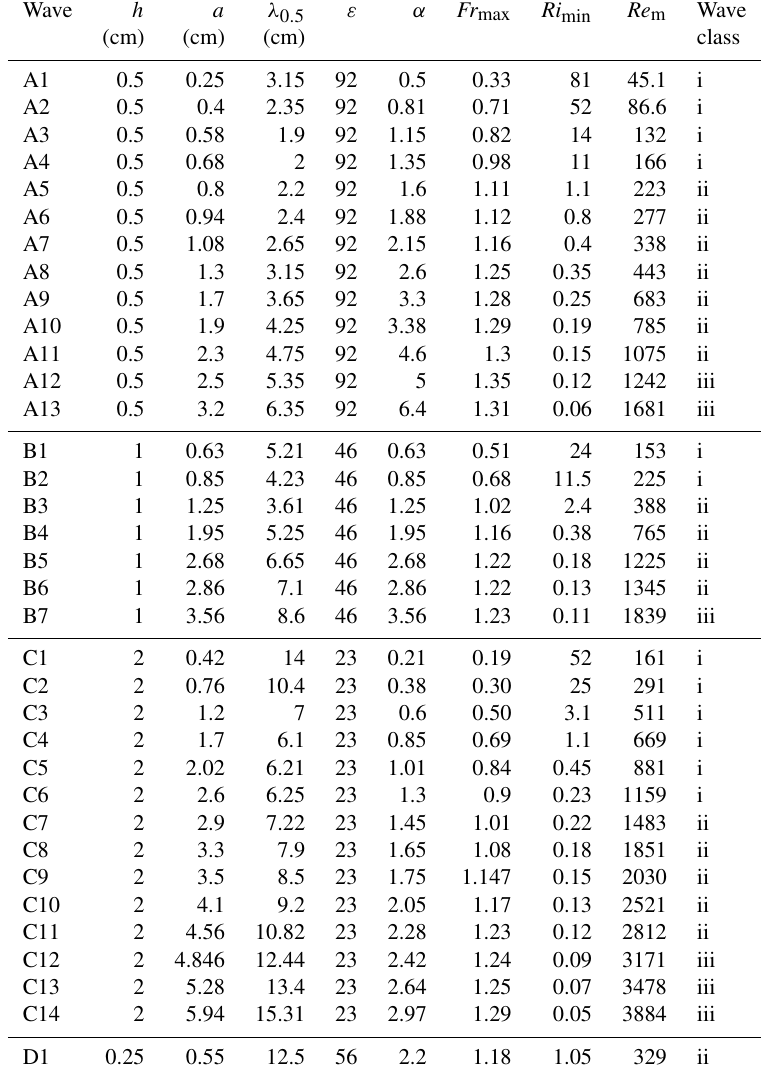
Table 1. Summary of parameters of interacting ISWs: pycnocline thickness parameter h , wave amplitude a , wavelength λ 0 . 5 , ratio ε , dimen- sionless ISW amplitude α , Froude number Fr max , minimum Richardson number Ri min , Reynolds number Re m , and ISW